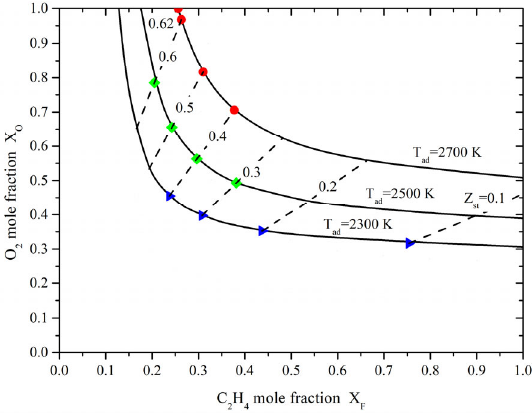
Figure 4. Iso ‐ T ad and iso ‐ Z st curves in O 2 /CO 2 atmosphere. Figure 4. Iso-T ad and iso-Z st curves in O 2 /CO 2 atmosphere.